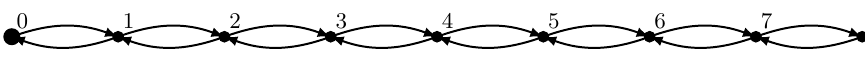
Figure 1: Standard symmetric random walk on the non-negative integers.